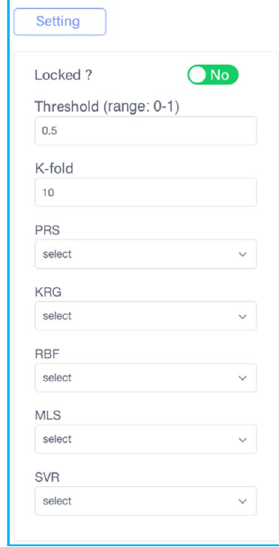
Figure 10 The configuration pane of the E-AHF block